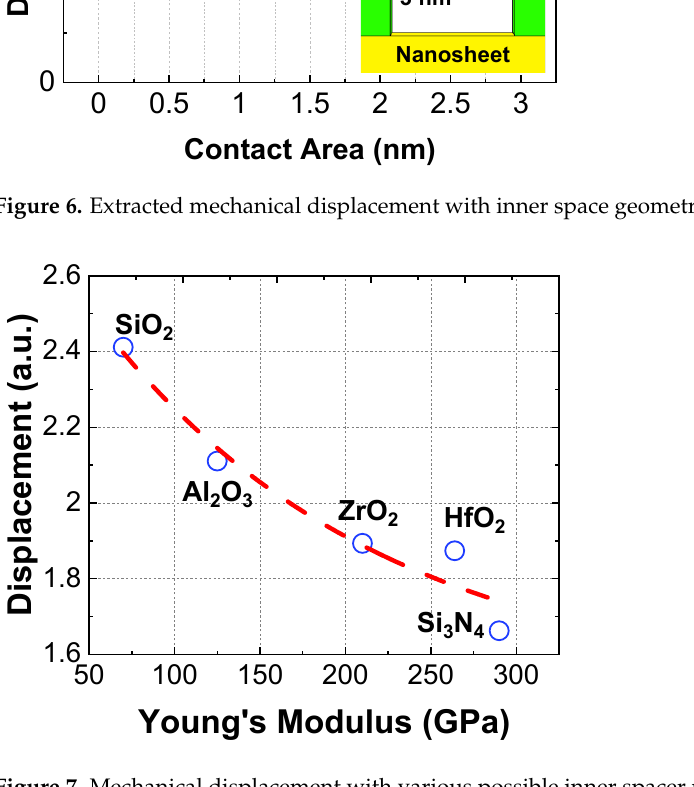
Figure 7. Mechanical displacement with various possible inner spacer materials.